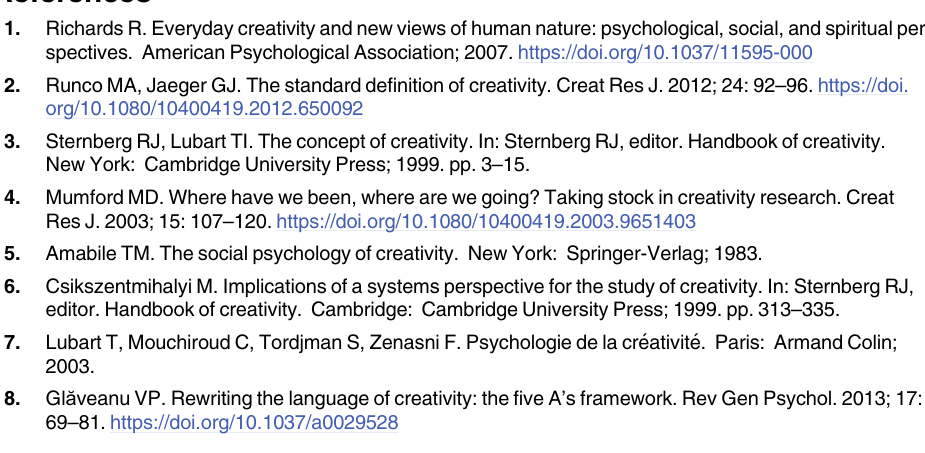
S3 Table. Results of multiple regression analysis in the effect of flexibility with creative achievement score as the objective variable. S4 Table. Results of multiple regression analysis in the effect of originality with creative achievement score as the objective